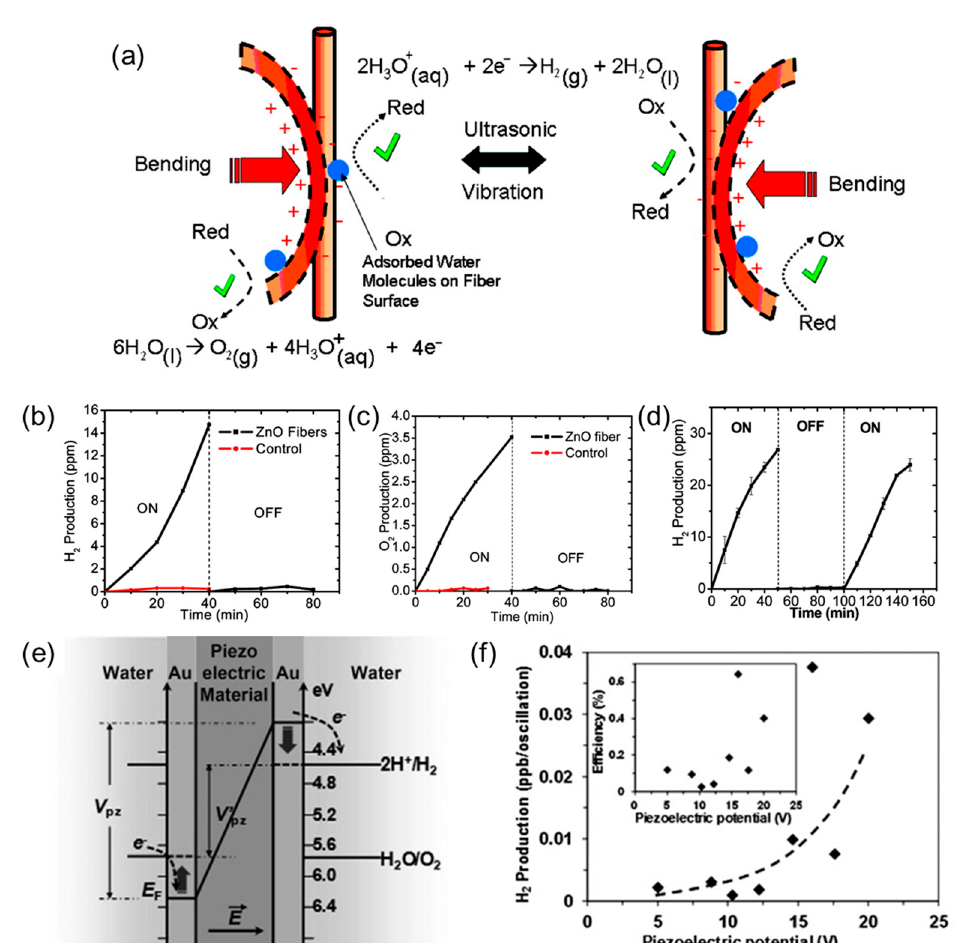
Figure 3. ( a ) Illustration of H 2 and O 2 generation mechanisms assisted by the piezoelectric energy harvesting. Evolution of ( b ) H 2 and ( c ) O 2 as a function of time using the piezoelectric ZnO nanowires. ( d ) H 2 evolution performance of as-synthesized BaTiO 3 dendrite. ( e ) Schematics of piezoelectric potential drive water splitting mechanism. ( f ) H 2 production rate as a function of piezoelectric potential where the inset shows the corresponding catalytic efficiency. ( a – d ) Reproduced from [33], Copyright 2010, American Chemical Society. ( e , f ) Reproduced from [34], Copyright 2012, Wiley-VCH Verlag GmbH & Co. KGaA, Weinheim.